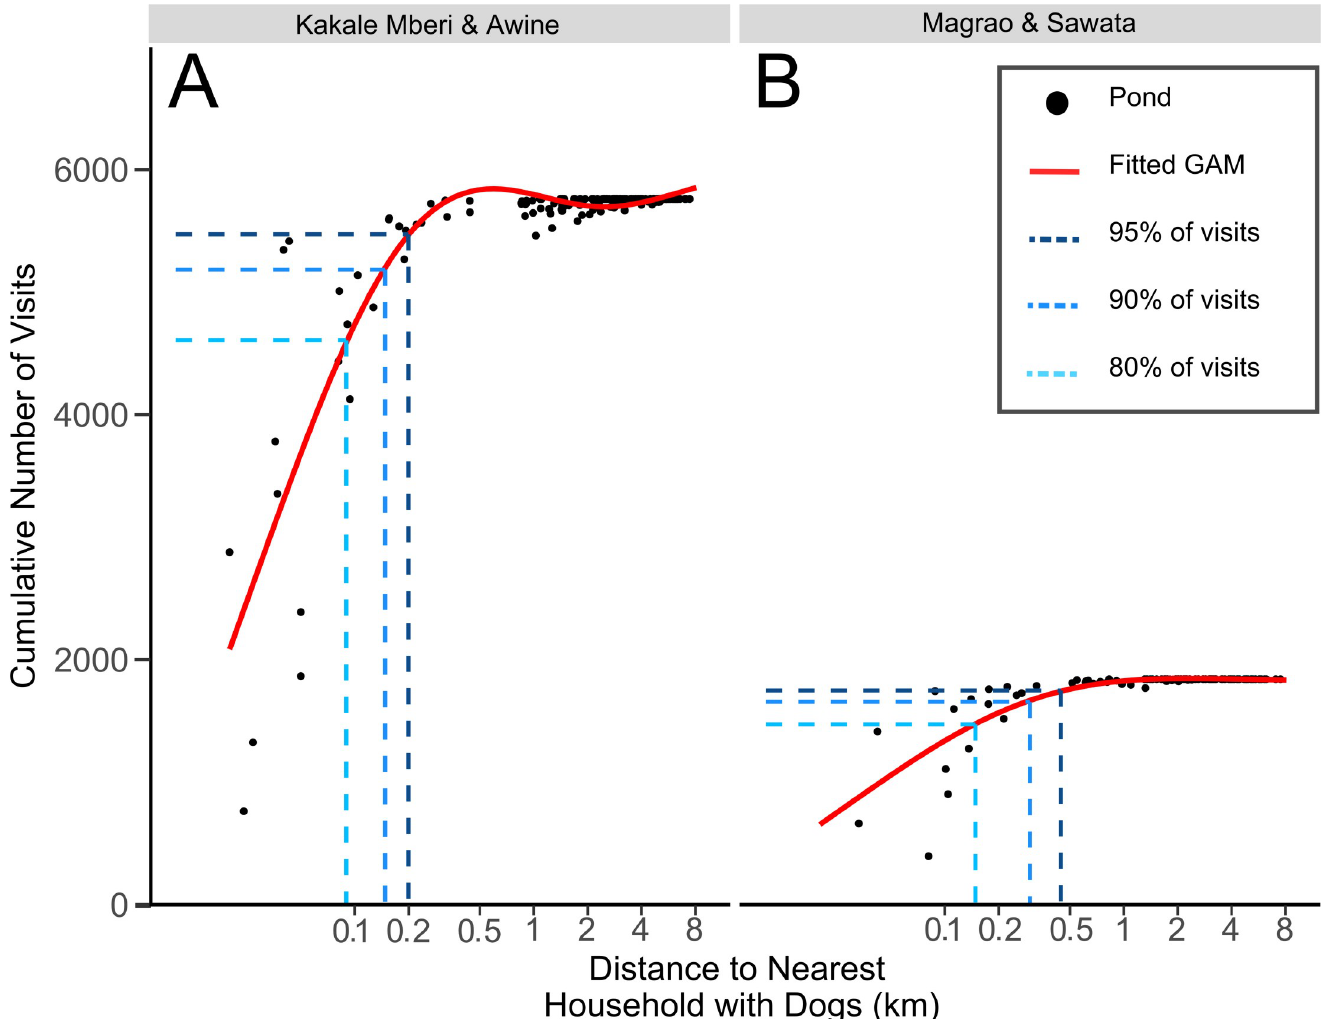
Fig 2. Distances from human households of the ponds most exposed to visits by dogs in two settlements in Chad. A is Kakale and B is Magrao. Dog visits were determined by locating dogs within 100m of a pond by GPS tracking. Ponds were located from satellite imagery within a search area enclosing all dog location points for each village and are a sub-sample of all available ponds. All visits by all dogs were summed for each pond and the cumulative total of all dog visits is plotted against the distance of the pond to the nearest household with tracked dogs, with the red line from a fitted generalised additive model. The dotted lines indicate the distance from a household with dogs at which 80%, 90% and 95% of all dog visits are